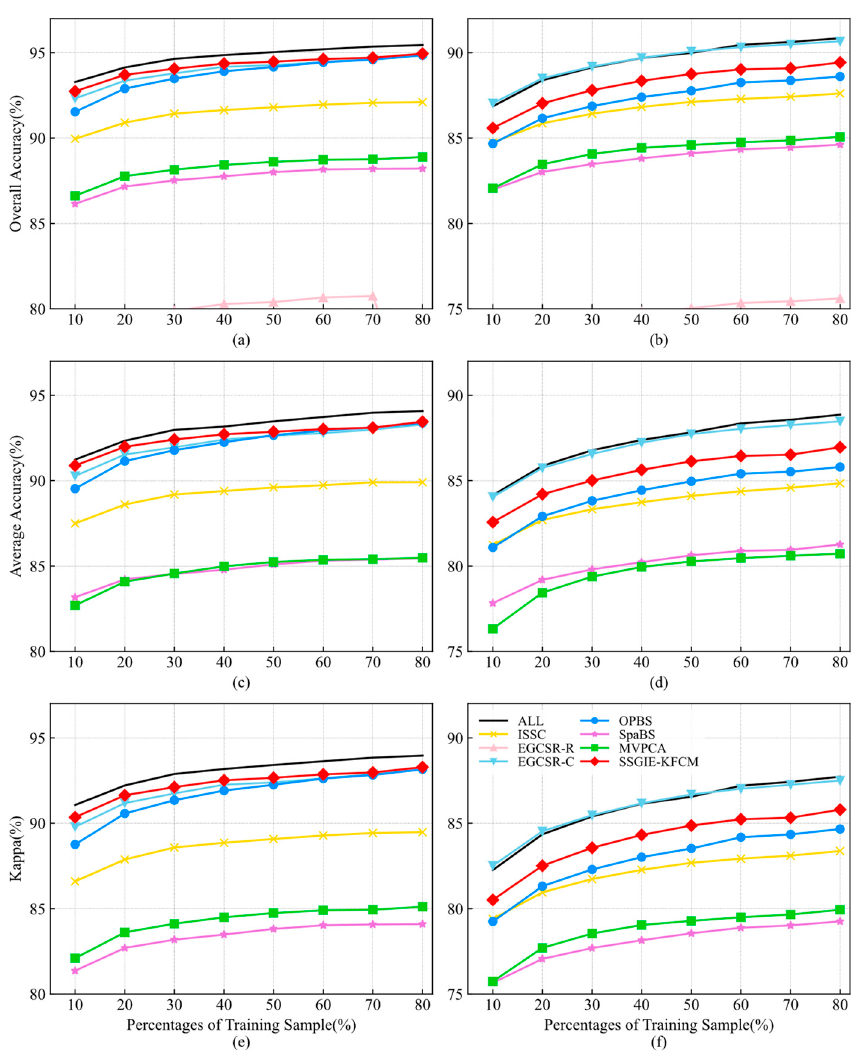
Figure 9. Classification accuracy of different band selection methods on the Pavia University dataset with 18 bands and different training sample sizes. ( a , c , e ) are SVM classifiers; ( b , d , f ) are KNN clas- sifiers.